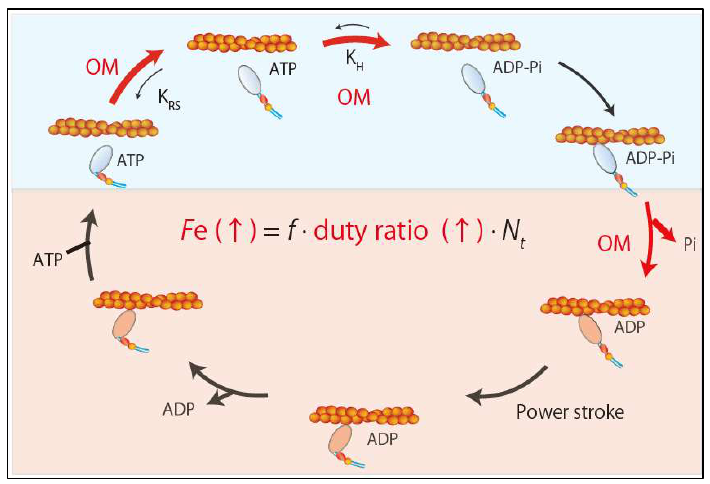
Figure 4. E ff ects of omecamtiv mecarbil. Omecamtiv mecarbil increases the ensemble force by Figure 4. Effects of omecamtiv mecarbil. Omecamtiv mecarbil increases the ensemble force by increasing duty ratio. increasing duty